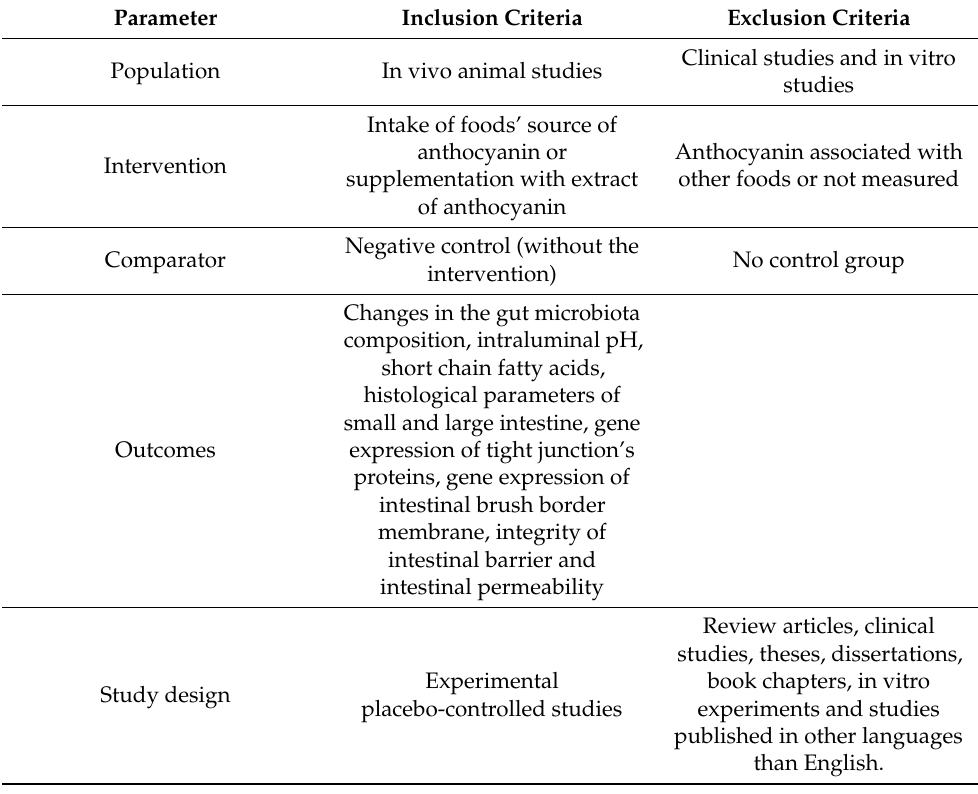
Table 1. PICOS criteria for inclusion and exclusion of